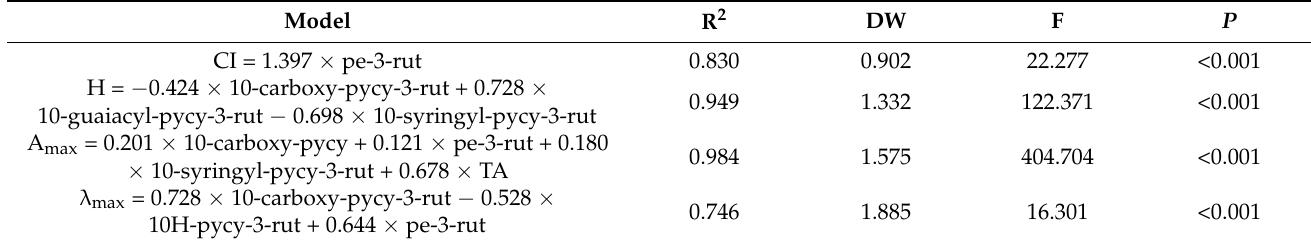
Table 3. Anthocyanins and anthocyanin-derived compounds identified in the cherry wines by UPLC-MS. Model R 2 DW F P CI = 1.397 × pe-3-rut 0.830 0.902 22.277 <0.001 H = − 0.424 × 10-carboxy-pycy-3-rut + 0.728 × 0.949 1.332 122.371 <0.001 0.984 1.575 404.704